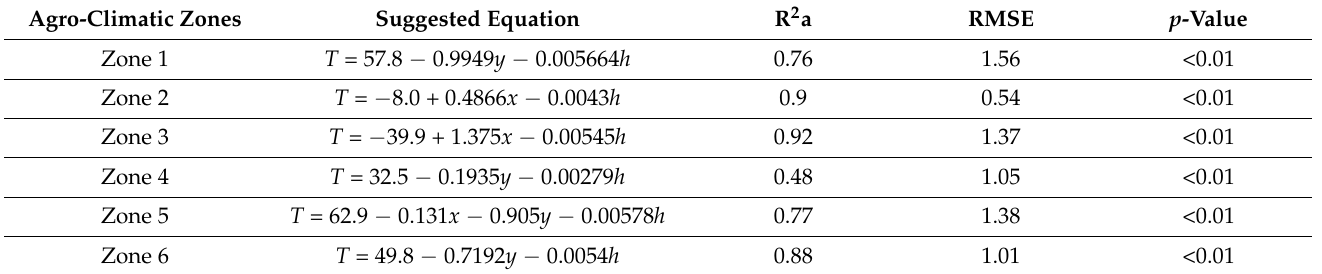
Table 3. Relationship between the annual mean temperature and the components of the geographical coordinates in six agro-climatic zones.